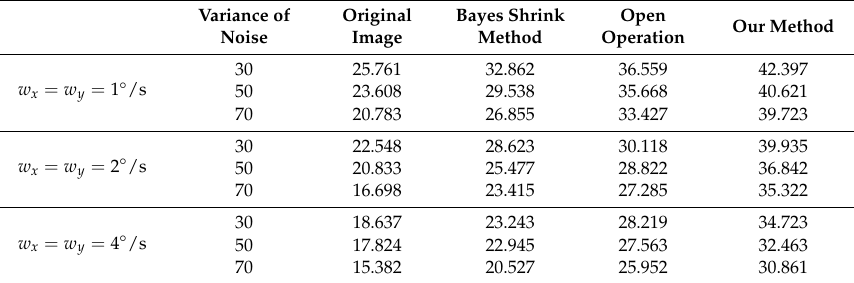
Table 2. Signal-to-noise ration (PSNR) for each with various noise